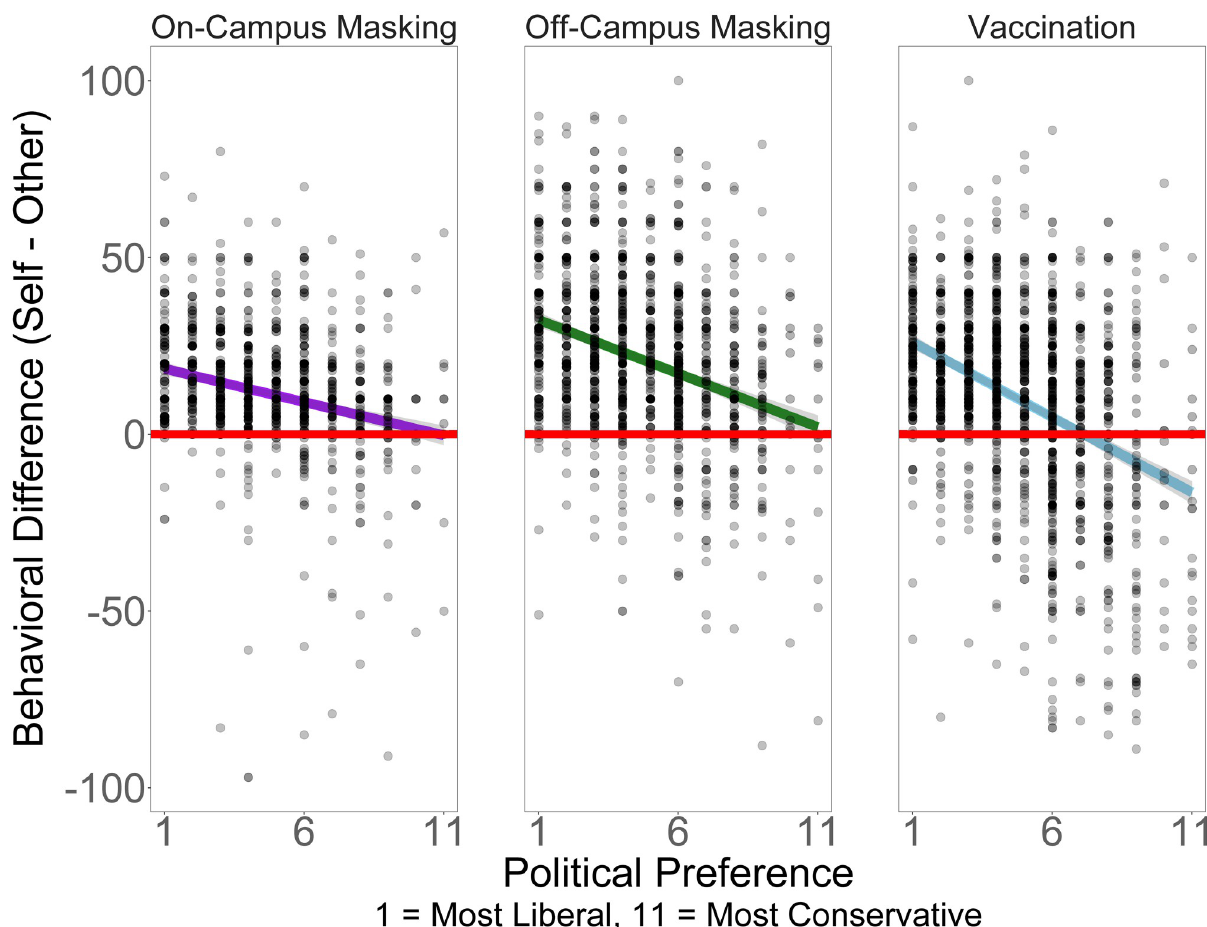
Fig 3. Plots of self-other differences for each health behavior outcome as a function of political preference. Higher values of x indicate more conservative political preference. (a) Association with on-campus masking ( β = -1.88 [-2.29, -1.47]). (b) Association with off-campus masking ( β = -3.04 [-3.53,-2.55]). (c) Association with vaccination ( β = -4.24 [-4.72, -3.78]).